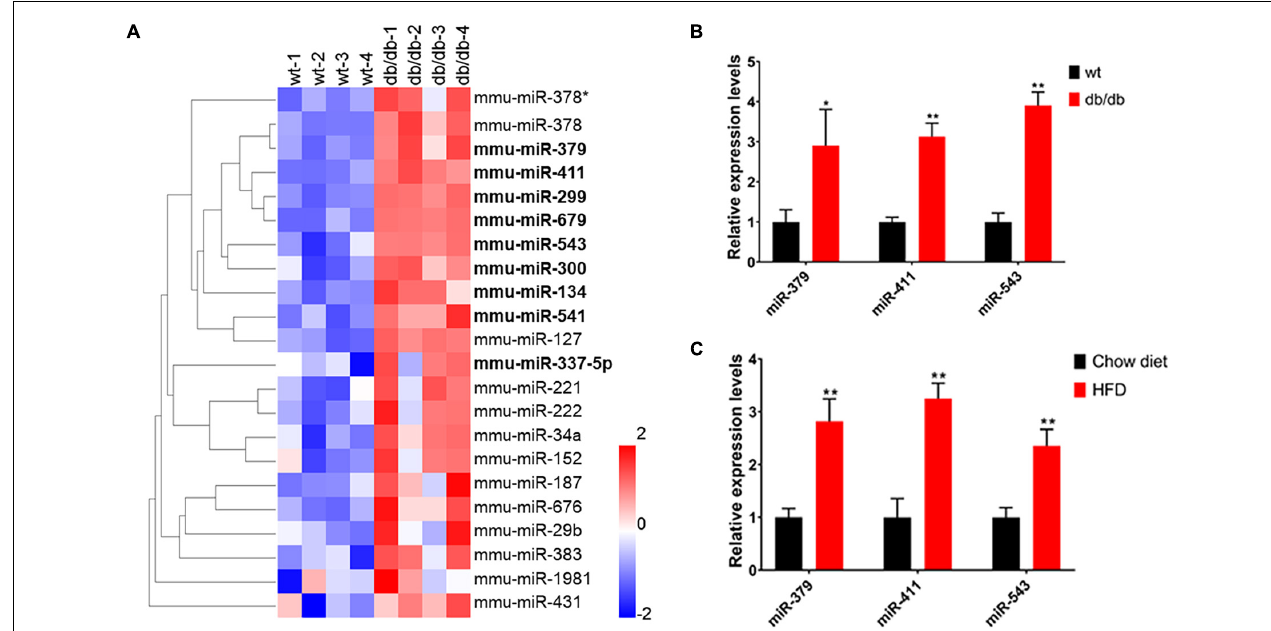
FIGURE 1 | The miR-379/miR-544 cluster expression is upregulated in the steatotic liver of db/db mice and HFD-fed mice. (A) Heatmap showing relative miRNA expression between wild-type (wt) and db/db mice ( n = 4). The higher and lower expression is showed with red and blue color, respectively. Nine significantly upregulated miRNAs ( miR-379, miR-411, miR-299, miR-679, miR-543, miR-300, miR-134, miR-541, and miR-337-5p ) located in the miR-379/miR-544 cluster are shown with bold font. Differentially regulated miRNAs are defined with fold changes ≥ 2-fold, P < 0.05. (B,C) Hepatic expression levels of miR-379, miR-411 , and miR-543 were determined by real-time PCR in chow-fed 10-12-week-old db/db mice (B) and WT mice ( n = 4) fed an HFD for 10 weeks starting at 4 weeks of age (C) . *P < 0.05 and **P <